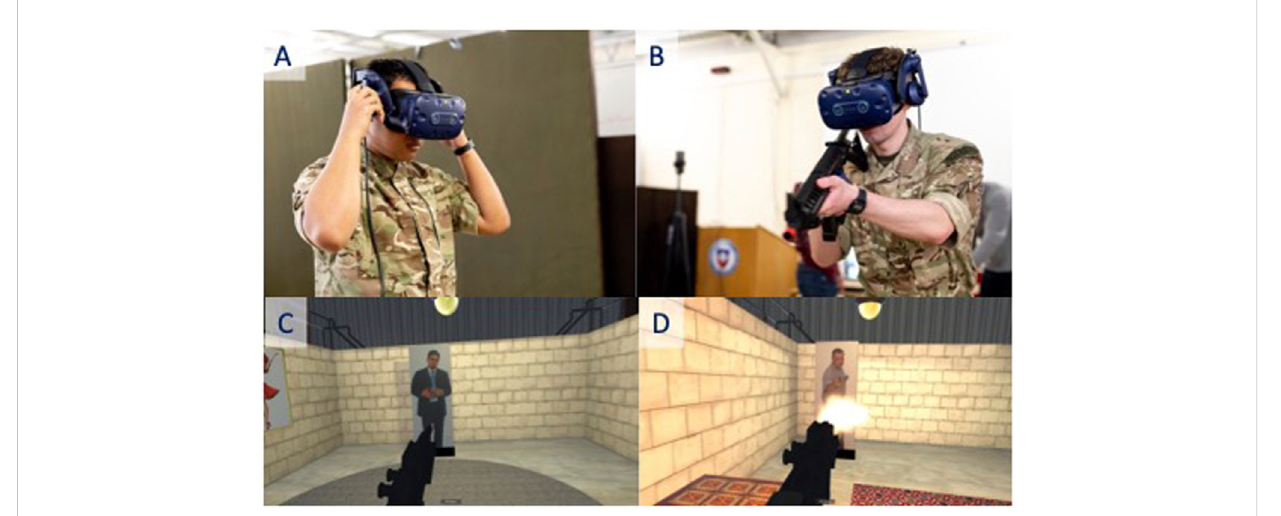
FIGURE 1 VR Hardware and software. The HTC Vive Pro VR head mounted display (A) , the position tracked replica weapon (B) , and in-play screenshots (C, D) . Images are property of RAF Honington and protected by Crown Copyright © . Reproduced with permission.